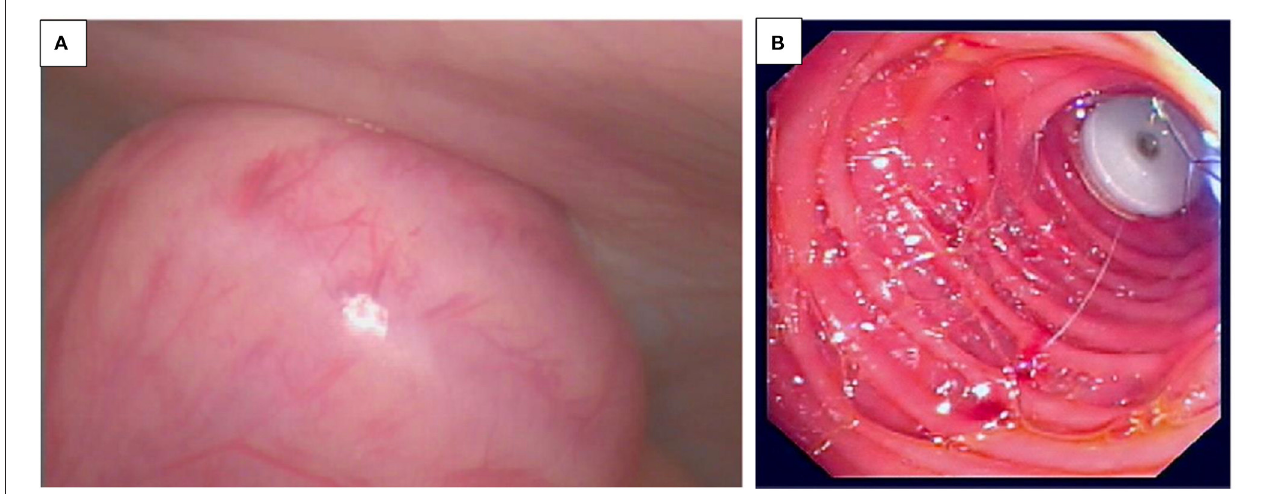
FIGURE 11 | (A,B) Laparoscopic-assisted percutaneous endoscopic jejunostomy (LAPEJ). (A) Laparoscopic view of the proximal jejunum pulled to the abdominal wall by PEG tube insertion. (B) Endoscopic view of the Corflo in the